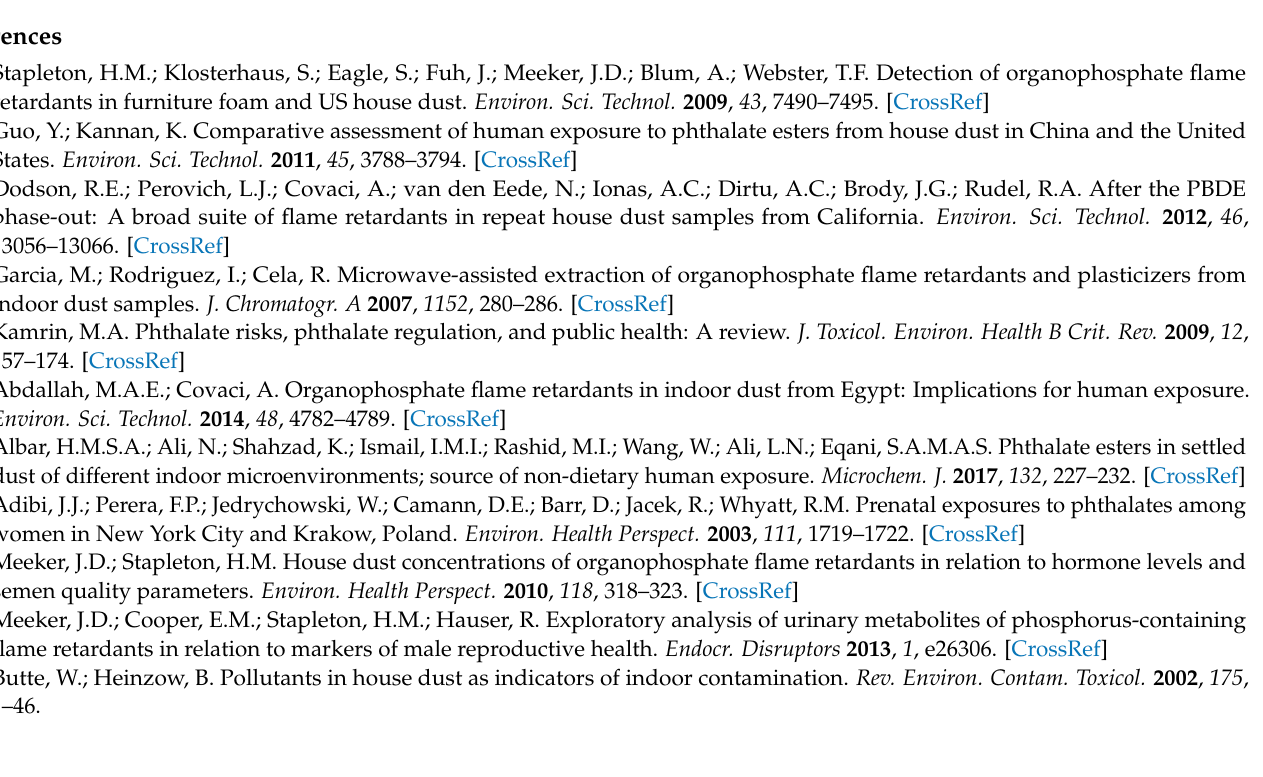
2585. Table S2. Concentrations (ng/m 3 ) of analyzed OPEs and phthalates in indoor air reported from different countries. Table S3. Concentrations and range (ng/g) of dust OPEs in indoor dust reported from different countries. Table S4. Concentrations (ng/g) of dust phthalates in indoor dust reported from different